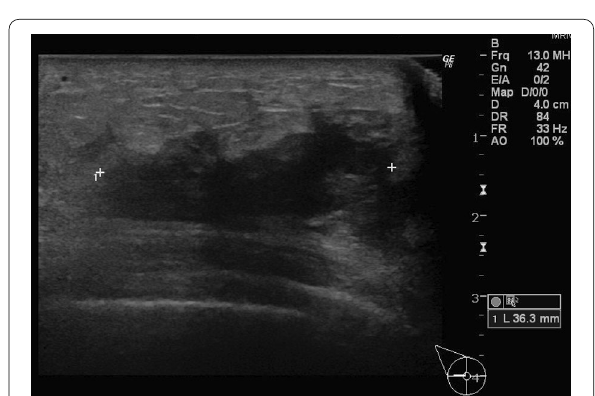
Fig. 2 Breast ultrasonography revealed a 36-mm irregular mass at the 9 o’clock